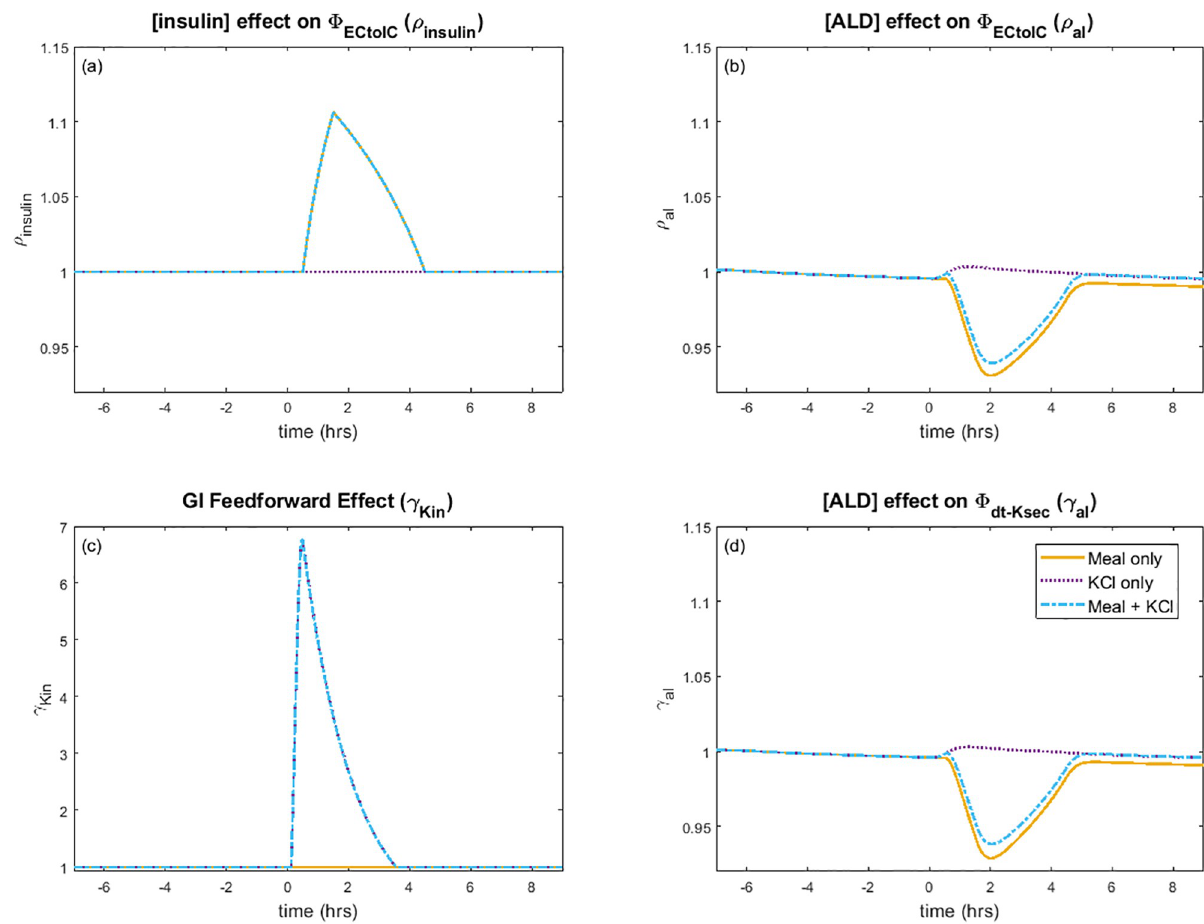
Fig 6. Feedforward and feedback response to a single meal. Model simulation predictions for (A) effect of insulin concentration ([insulin]) on Na + - K + -ATPase K + uptake, (B) aldosterone concentration effect on Na + -K + -ATPase K + uptake, (C) gastrointestinal (GI) feedforward effect on distal tubule K + secretion, and (D) aldosterone effect on distal tubule K + secretion. The meal experiment occurs at 0 hours. Initial conditions are steady state with a fasting state set before the meal experiment. The yellow lines denote the K + deficient meal (i.e., “Meal only” experiment); purple, only K + ingestion (i.e., “KCl only” experiment); blue, meal with K + (i.e., “Meal + KCl”